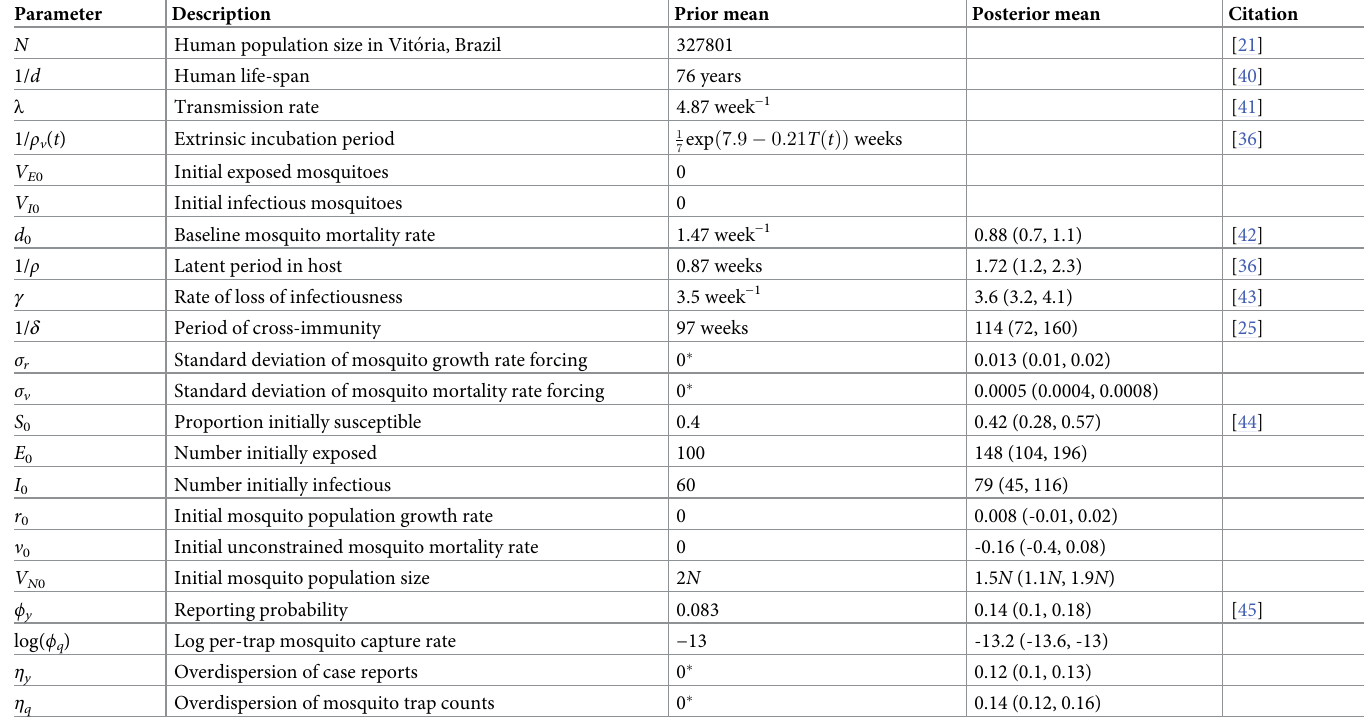
Table 1. Model parameters and their values. The values in parentheses after the posterior means give the 80% credible interval. See S1 Text for a full description of all prior distributions. Parameter Description Prior mean Posterior mean